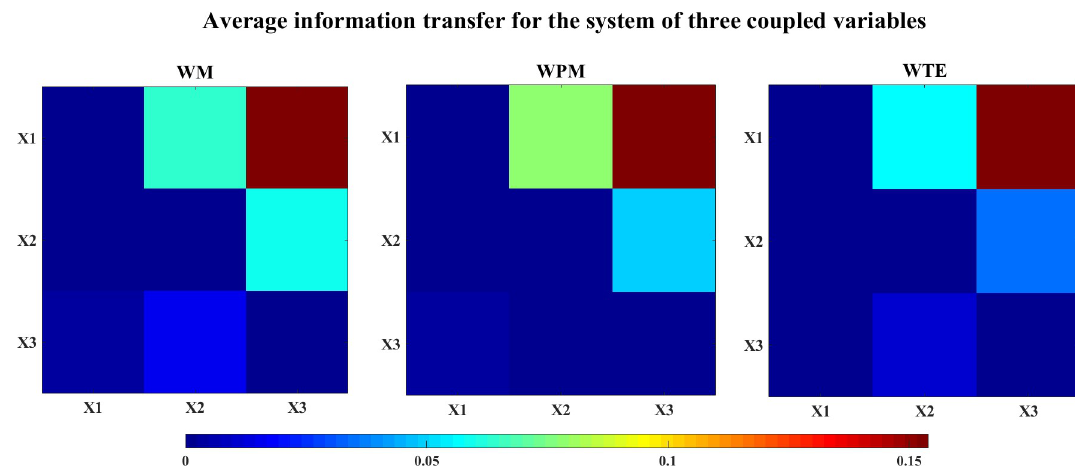
Fig 12. The color-map of the average information transfer values for the system of three coupled variables. The three color-maps show the average WM (left), WPM (middle) and WTE (right) values for the system of three coupled variables. The directed direction of each lattice is indicated from the row channel to the column channel. Comparing the information transfer values between opposite directions, all measures identify the correct linear (X2- > X3) and nonlinear (X1- > X2, X1- > X3) interactions.